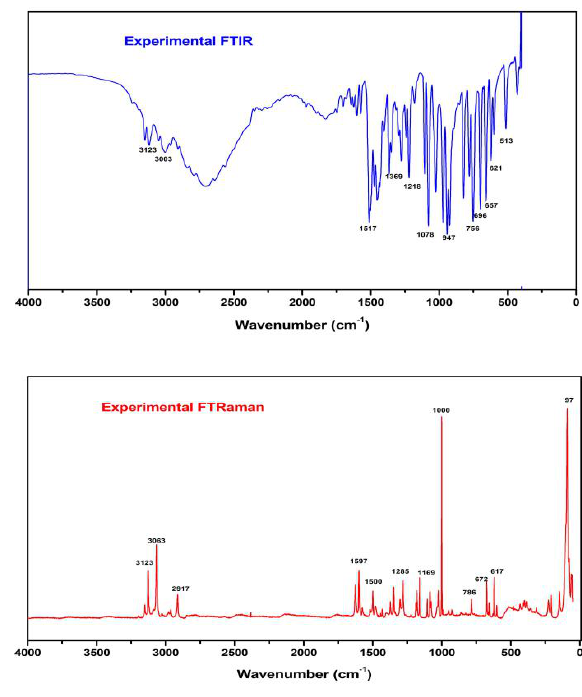
Figure 8: Experimental FT-IR and FT-Raman and spectra of the IPAONM molecule.